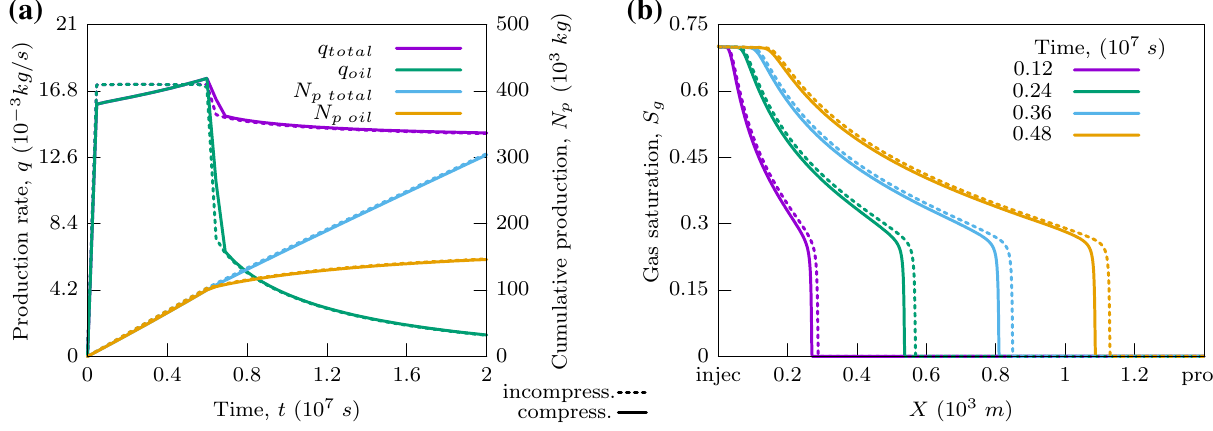
Fig. 5 Injectant gas CO 2 . 1D model. Scenario 3. Comparison of compressible and incompressible cases. a Production profiles. b Saturation pro-